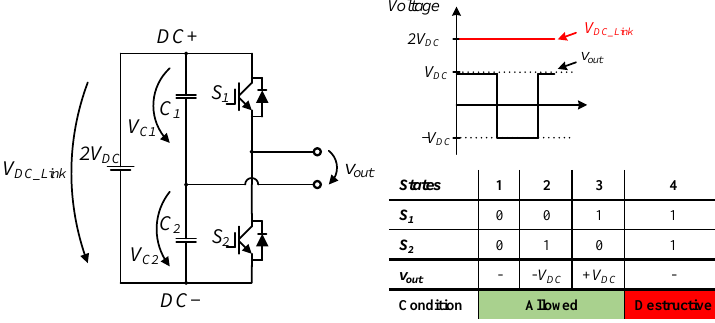
Figure 3. Half-bridge with split DC bus topology and operation principle.